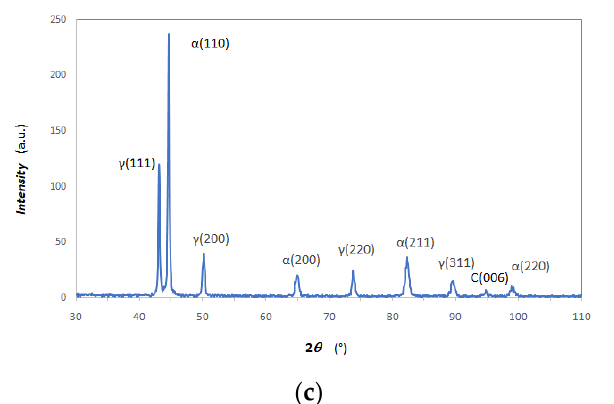
Figure 8. Typical XRD patterns of ausferrite (1.5 wt% of Ni, 25 mm Y-blocks) after different austempering conditions: ( a ) 250 °C with 6 h; ( b ) 310 °C for 3 h and ( c ) 380 °C for 1 h.